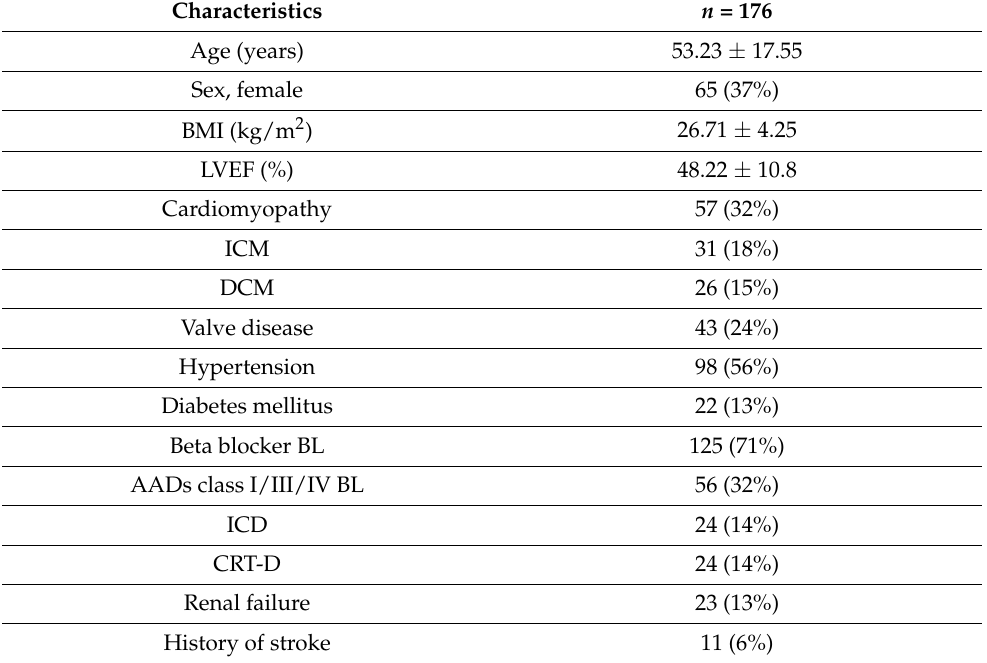
Table 1. Baseline